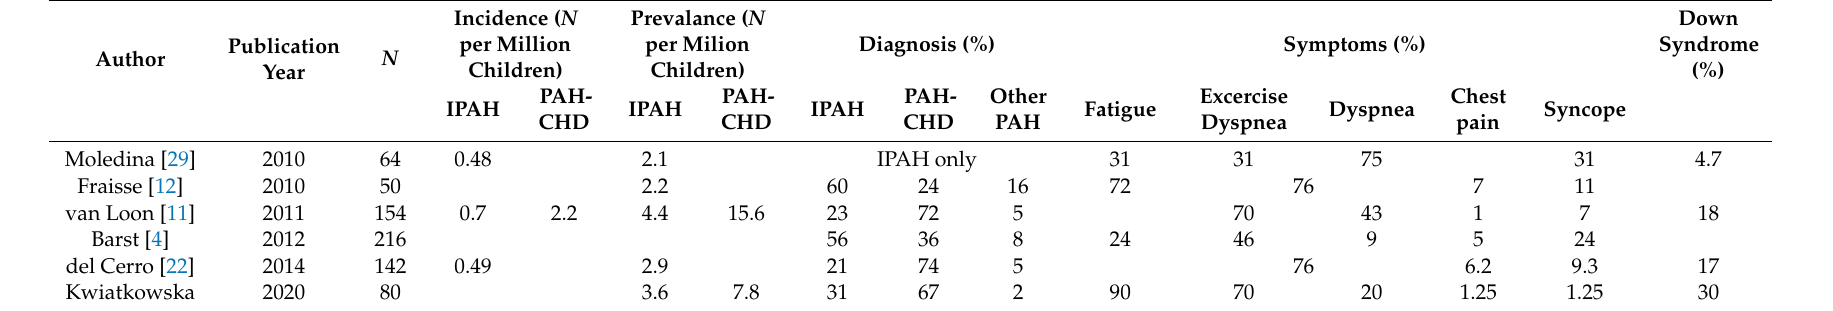
Table 5. Review of pediatric pulmonary hypertension